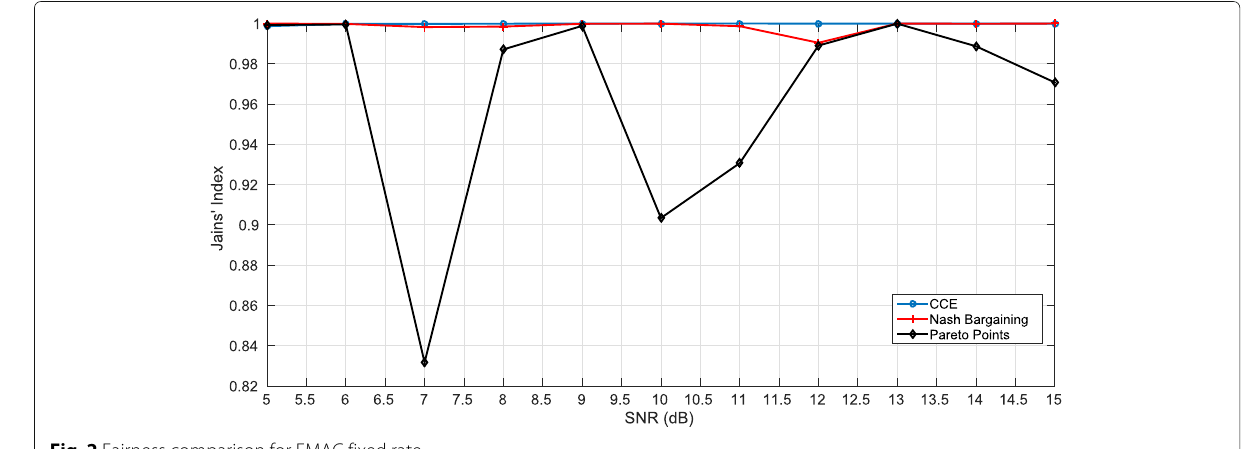
Fig. 2 Fairness comparison for FMAC fixed rate